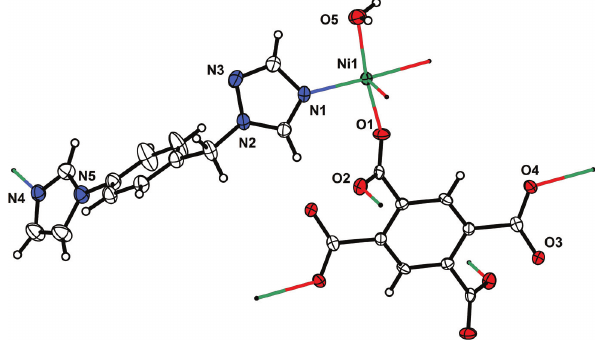
Table 1: Data collection and handling.